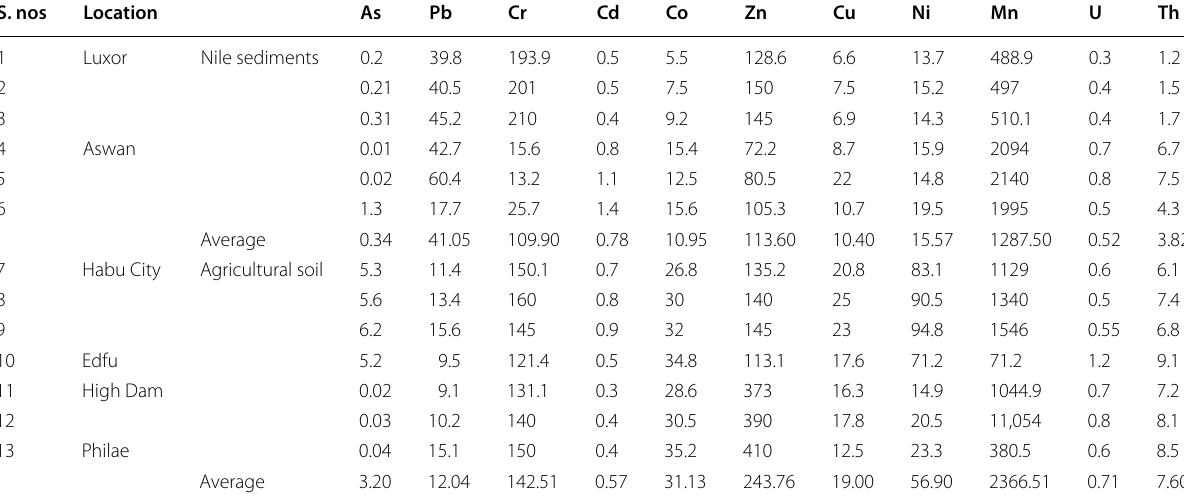
As, Pb, Cr, Cd, Co, Zn, Cu and Ni averages after Abou El‑Anwar (2019)